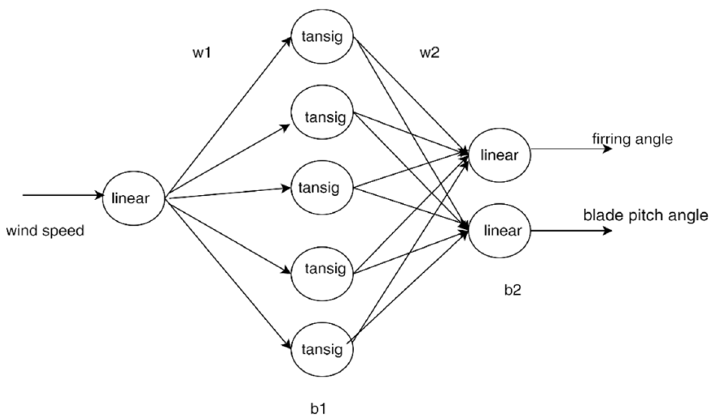
Figure A4. flowchart of ANN-LQG controller.